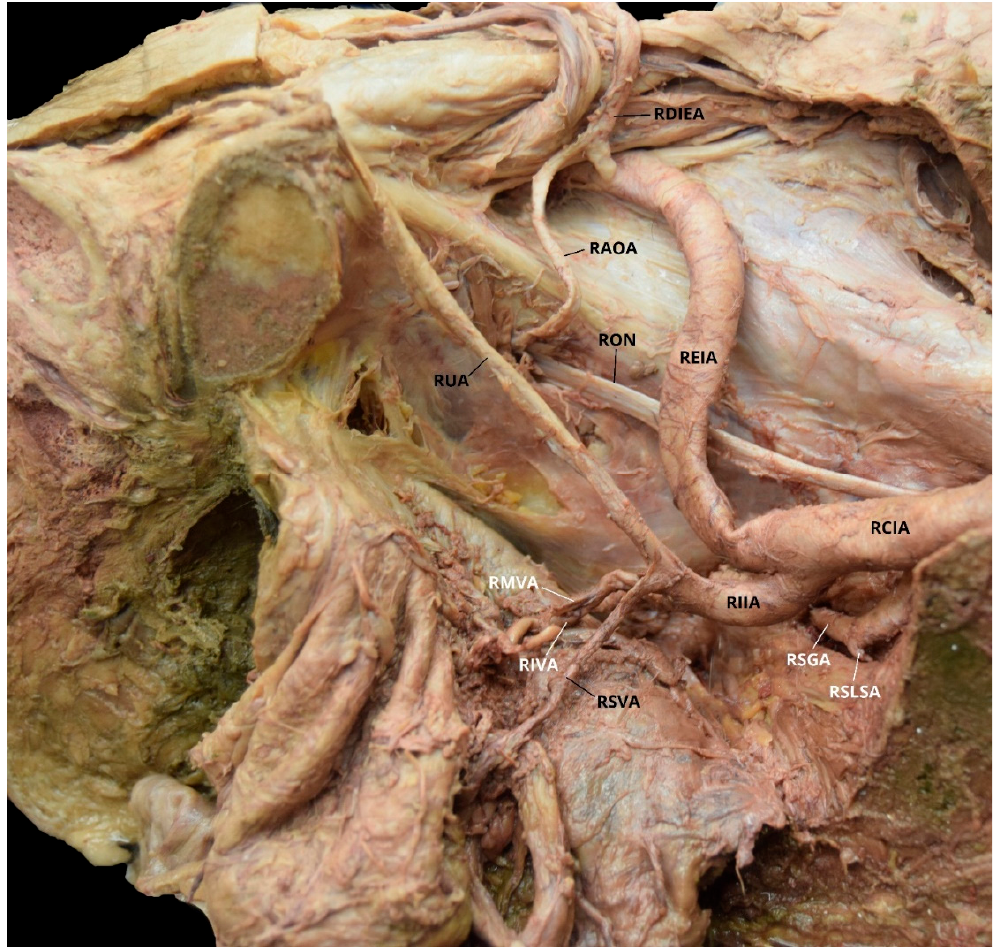
Figure 4. Facilitated display highlighting the right internal iliac artery branches with the right aberrant obturator artery for Case 2. RAOA = Right Aberrant Obturator Artery; RCIA = Right Common Iliac Artery; RDIEA = Right Deep Inferior Epigastric Artery; REIA = Right External Iliac Artery; RIIA = Right Internal Iliac Artery; RIVA = Right Inferior Vesical Artery; RON = Right Obturator Nerve; RMVA = Right Middle Vesical Artery; RSGA = Right Superior Gluteal Artery; RSLSA = Right Superior Lateral Sacral Artery; RSVA = Right Superior Vesical Artery; RUA = Right Umbilical Artery. The Right Inferior Gluteal Artery (RIGA), Right Iliolumbar Artery (RILA), Right Inferior Lateral Sacral Artery (RILSA), Right Internal Pudendal Artery (RIPA), and the Right Middle Rectal Artery (RMRA) are not